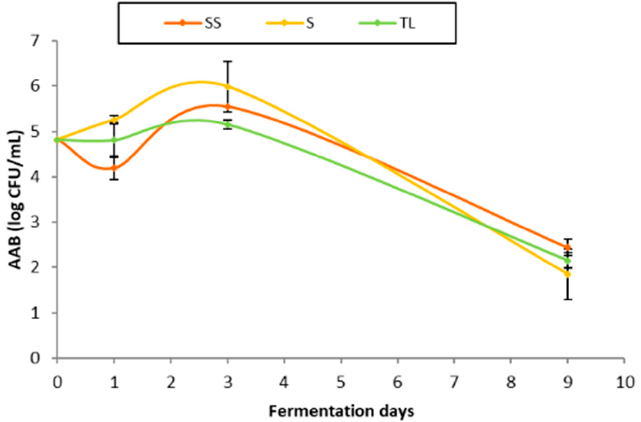
Figure 6. AAB population (log CFU/mL) throughout AF in the different inoculation strategies (SS: spontaneous sulfite, S: spontaneous without SO 2 , TL: inoculation with T. delbrueckii / L. thermotolerans at vatting without SO 2 ).